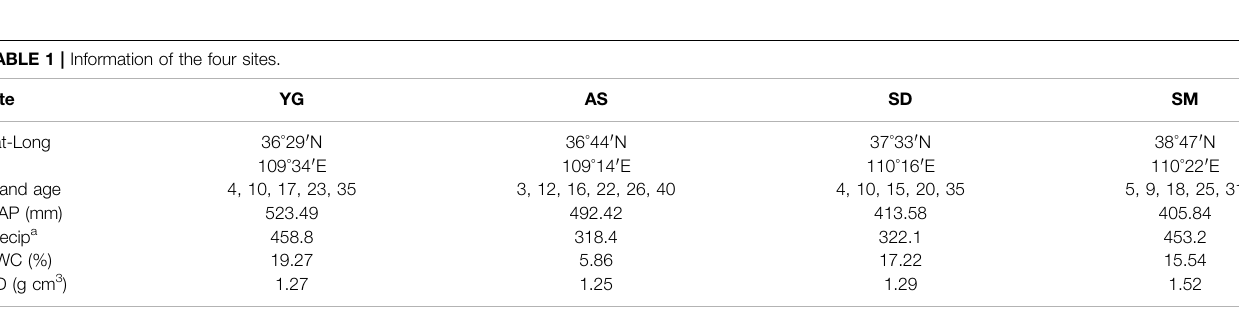
TABLE 1 | Information of the four